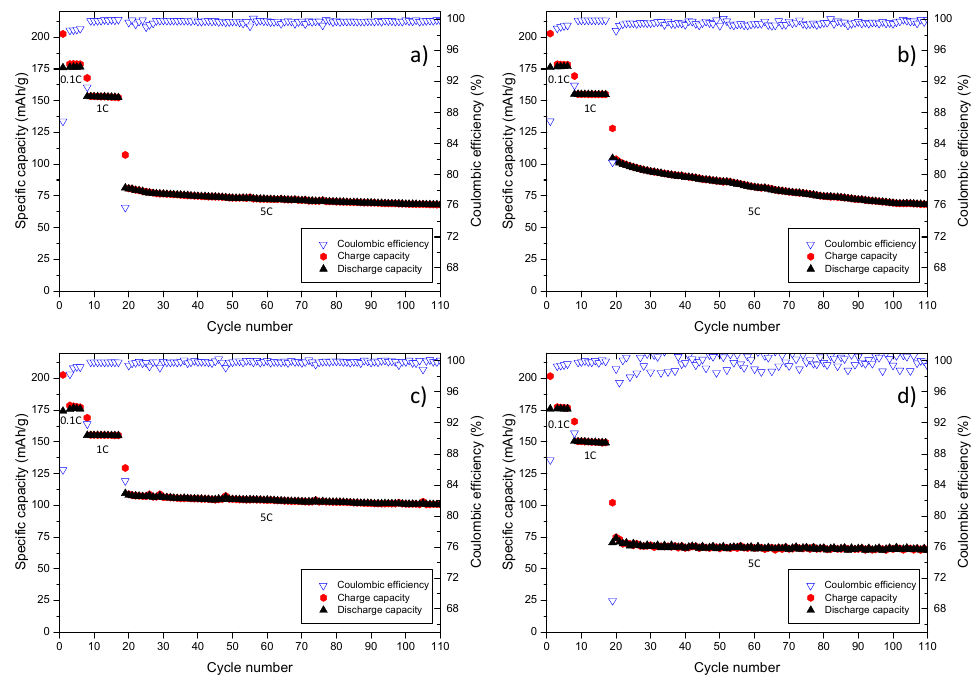
Figure 4. C-rate evaluation of the NMC / graphite cells containing ( a ) 1M LiPF 6 in BN:EC (1:1), ( b ) 1M LiPF 6 in BN:EC (7:3) + 1% FEC, ( c ) 1M LiPF 6 in BN:EC (9:1) + 3% FEC and ( d ) 1M LiPF 6 in EC:DMC (1:1) in the voltage range of 3.00–4.30 V.